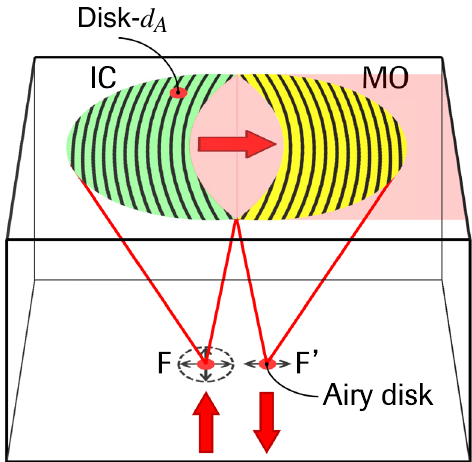
FIG. 3. Perspective view of the imaging system with optically conjugated foci F and F 0 . Both the area of the input coupler (IC) (green region) and the area of the mologram (MO) (yellow region) are restricted to lunes, i.e., a lunar